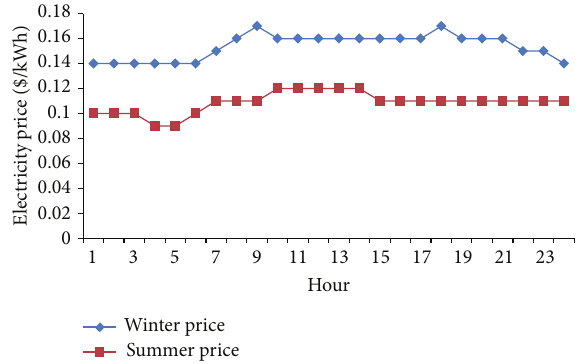
Figure 4: Seasonal hourly electricity price for household (including all fees) [39].